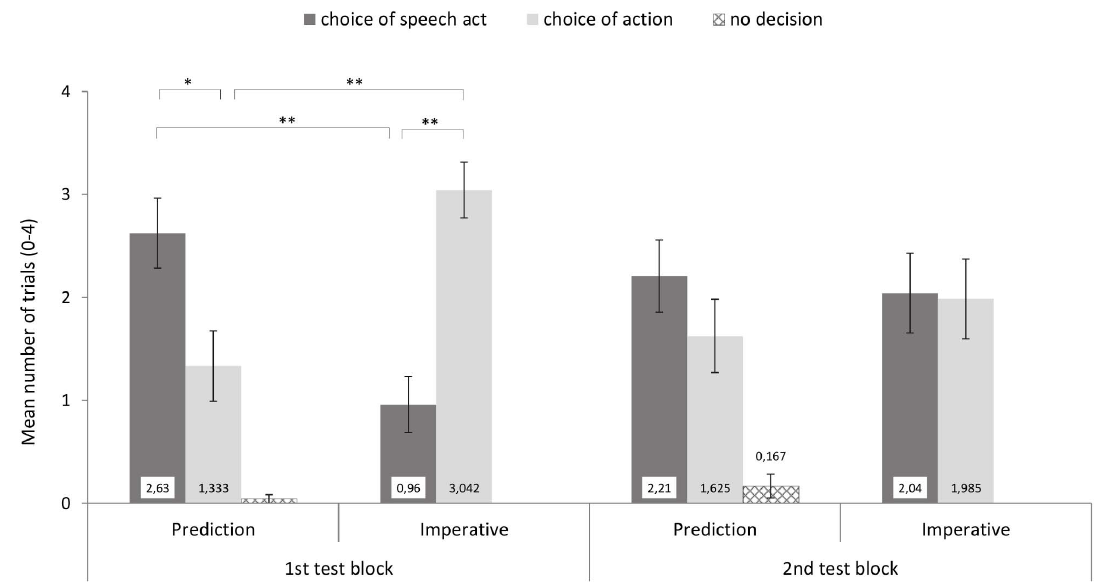
Figure 3. Responses to mismatches in Study 2 (forced-choice measure). ean sum scores of trials (0–4) with each type of decision (choice of picture depicting speech act, action, or no decision) as a function of condition (Prediction, Imperative) and order of test blocks (conditions were presented in blocks, with the order counterbalanced).